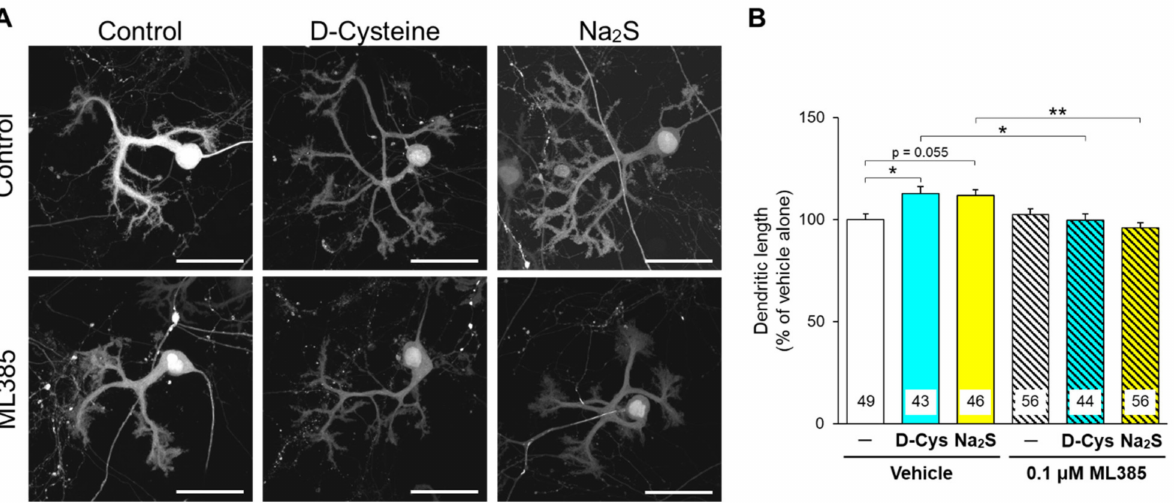
Figure 6. Effect of an Nrf2 inhibitor on the D-cysteine- and Na 2 S-induced enhancement of dendritic development in primary cultured PCs. ( A ) Fluorescent images of GFP-expressing PCs treated with D-cysteine (1 mM) and Na 2 S (10 µ M) in the presence of a vehicle (0.1% dimethyl sulfoxide) or ML385 (0.1 µ M) for 10 days. Scale bars are 50 µ m. ( B ) Quantitative analyses of the dendritic length of PCs shown in A. Numbers in the columns represent the numbers of observed cells. * p < 0.05, ** p < 0.01 (Turkey’s multiple comparisons test).